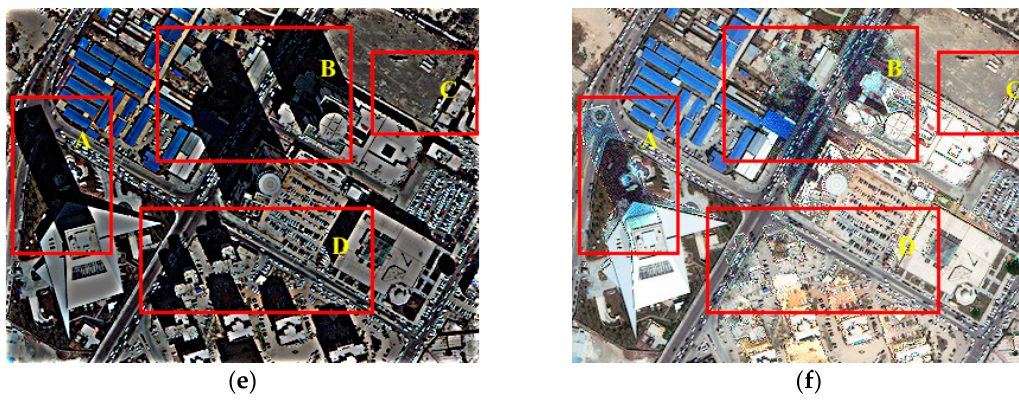
Figure 6. Shadow compensation results of various shadow compensation algorithms for the test image Tripoli-1. ( a ) The irradiance restoration based (IRB) method. ( b ) The linear correlation correction (LCC) method [16,21]. ( c ) The light source color rate (LSCR) method [33]. ( d ) The multi-scale Retinex (MSR) method [24,36]. ( e ) The homomorphic filtering (HF) method [25]. ( f ) The direct and environment light based method (DELM) [11,37] .